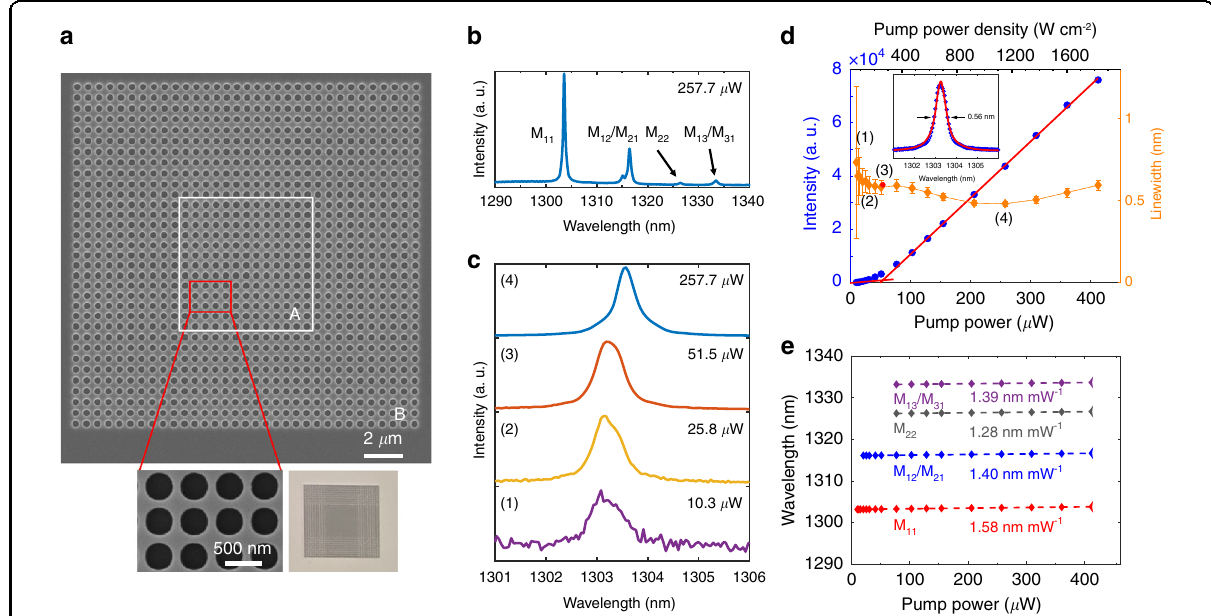
Fig. 2 Fabricated sample and the mini-BIC laser performance. a Scanning electron microscopy (SEM) images of the mini-BIC laser with a = 495 nm and N a = 13, the inset illustrates a magni fi ed view of the cavity region. The photonic heterostructure of the mini-BIC lasers can be clearly seen in the optical microscopy image (the lower panel). b The emission spectrum of a mini-BIC laser with a = 495 nm and N a = 13 under the pumping power of 257.7 μ W. The mode M 11 , M 12 /M 21 , M 22 and M 13 /M 31 can be observed at 1303, 1316, 1326 and 1333 nm, respectively. c Spectral evolution of lasing mode M 11 under various pumping power. d The collected emission intensity and the linewidth of the lasing M 11 peak at 1303 nm as a function of pumping power, indicating a lasing threshold of 52 μ W (227 W cm − 2 ). The inset is a Lorentzian curve fi tting of the spectra just below the threshold, which indicates a linewidth of ~0.56 nm and therefore a cavity Q factor of 2327. e The lasing wavelengths of each mode under various input pumping powers (diamonds) and their linear fi t (dashed lines). The error bars in ( c ) and ( d ) correspond to standard errors deduced by fi